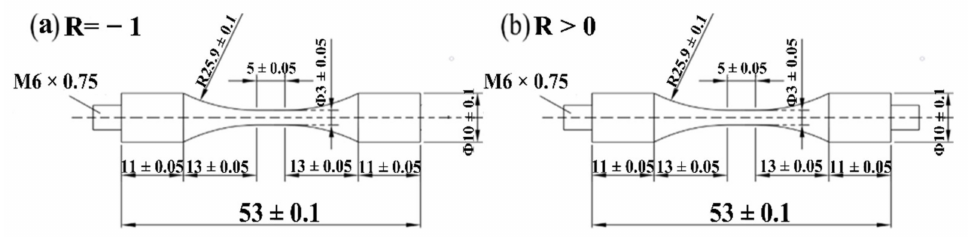
Figure 5. The dimensions of VHCF specimen: ( a ) R = − 1; ( b ) R > 0, (unit: mm). The scanning electron microscope (JSM-6510LV, Jeol Ltd. Tokyo, Japan) was used to observe and analyze the morphology of fracture surfaces after the fatigue tests, to capture information on the fatigue crack initiation and propagation mechanisms involved in the VHCF